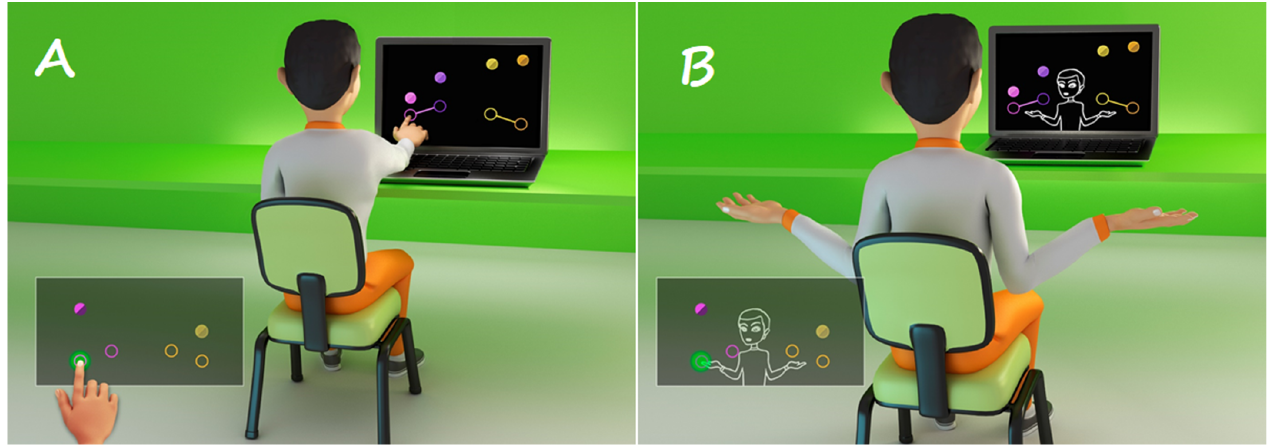
Figure 1. Representative design of a participant playing the MoveHero software task (Research group and technological application in rehabilitation—PATER group, São Paulo, Brazil), with the use of the ( A ) Touch Screen interface—real and ( B ) WebCam interface—virtual.